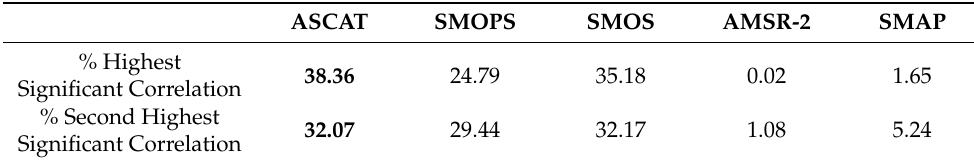
Table 3. Percent totals of each satellite SM dataset in for highest significant correlations and second highest significant correlation. Best and second-best performing datasets are indicated in bold.